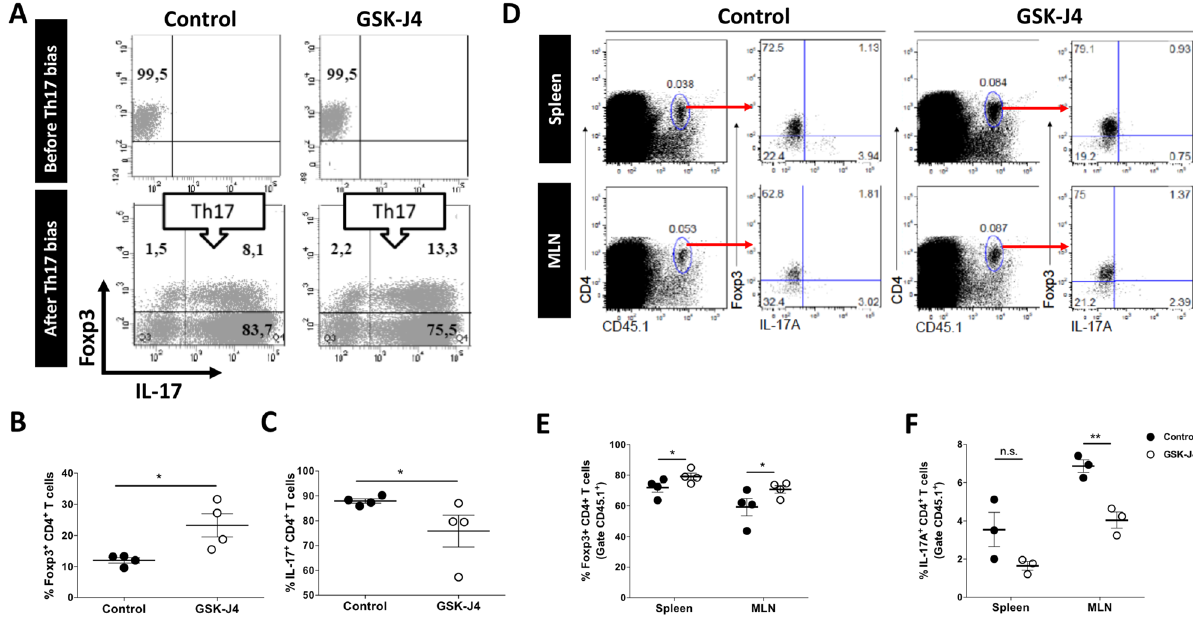
Figure 7. DCs exposed to GSK-J4 generate Treg with higher lineage stability. Naïve CD4 + CD25 − Foxp3 − T cells were isolated from Foxp3 GFP Cd45.1 +/+ Cd45.2 −/− mice by cell-sorting and activated with splenic DCs and anti-CD3 Ab under standard Treg polarising conditions in the absence (Control) or the presence of GSK-J4 25 nM. After 5 days of culture, GFP + CD4 + Treg cells were purified by cell-sorter. ( A – C ) Treg were incubated in Th17 biased conditions for 5 days and the level of Foxp3 and IL-17A expression was evaluated by flow cytometry. ( A ) Representative dot-plots of Treg before (top panels) or after (bottom panels) incubation under Th17 biased conditions. Numbers on the dot-plots indicate the percentage of cells in each quadrant. ( B – C ) Quantification of the Foxp3 + ( B ) and IL-17A + ( C ) frequency in the CD4 + T cell population. Each symbol represents data obtained from a single mouse (n = 4 per group). Mean ± SEM are shown. ( D – F ) Treg were i.v. transferred (7.5 × 10 5 cells per mouse) into WT Cd45.1 −/− Cd45.2 +/+ recipient mice which 24 h later received 1.5% DSS during 8 days. On day 10 after colitis induction, cells from the spleen and MLN were isolated and the extent of Foxp3 and IL-17A expression was analysed in the CD4 + CD45.1 + population by flow cytometry. ( D ) Representative dot-plots of CD4 versus CD45.1 and of Foxp3 versus IL-17A are shown. Numbers on the dot- plots indicate the percentage of cells in each region or quadrant. Red arrows indicate the gate analysed. (E–F) Quantification of the Foxp3 + ( E ) and IL-17A + ( F ) frequency in the CD4 + CD45.1 + population. Each symbol represents data obtained from a single mouse (n = 3–4 per group). Mean ± SEM are shown. * p < 0.05; ** p < 0.01 as determined by Student’s t-test ( B , C ) or two-way ANOVA followed by Sidak’s post-hoc test ( E , F ). n.s., not significant differences were